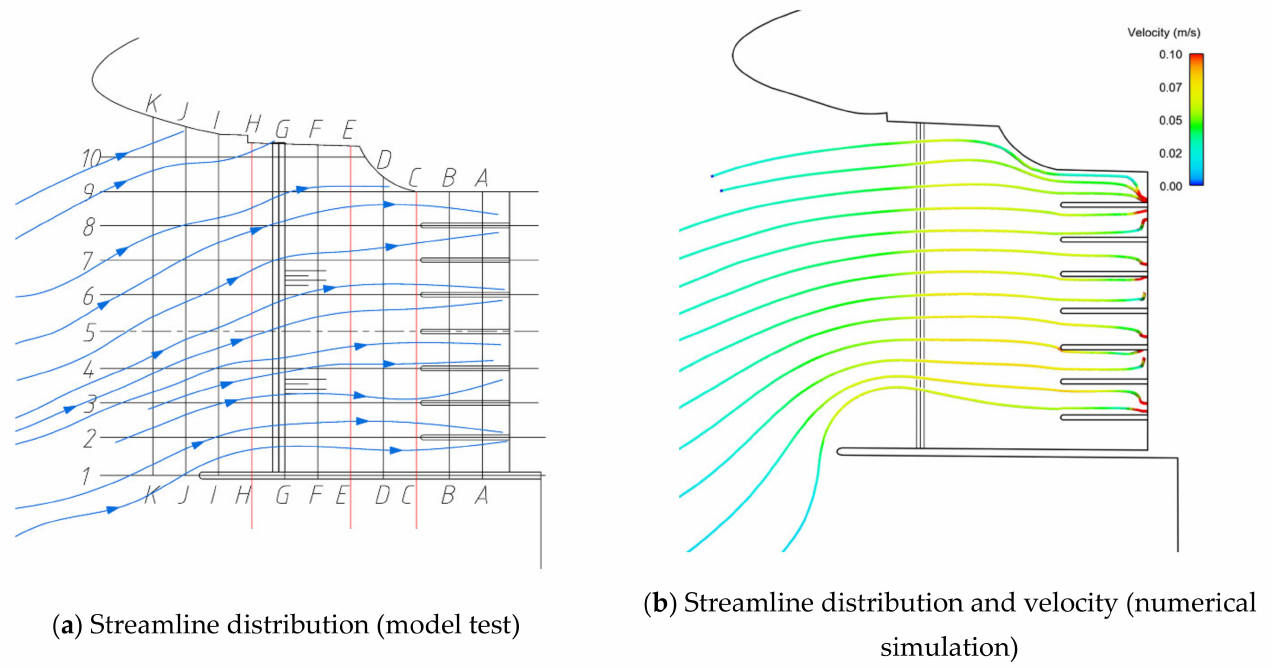
Figure 18. Plan 4 (design operating water